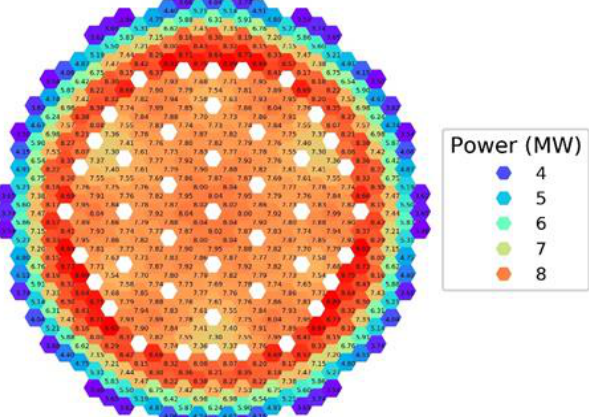
Figure 2. Power Distribution (MW) at EOEC for ESFR-SMART core, calculated using WIMS without thermal